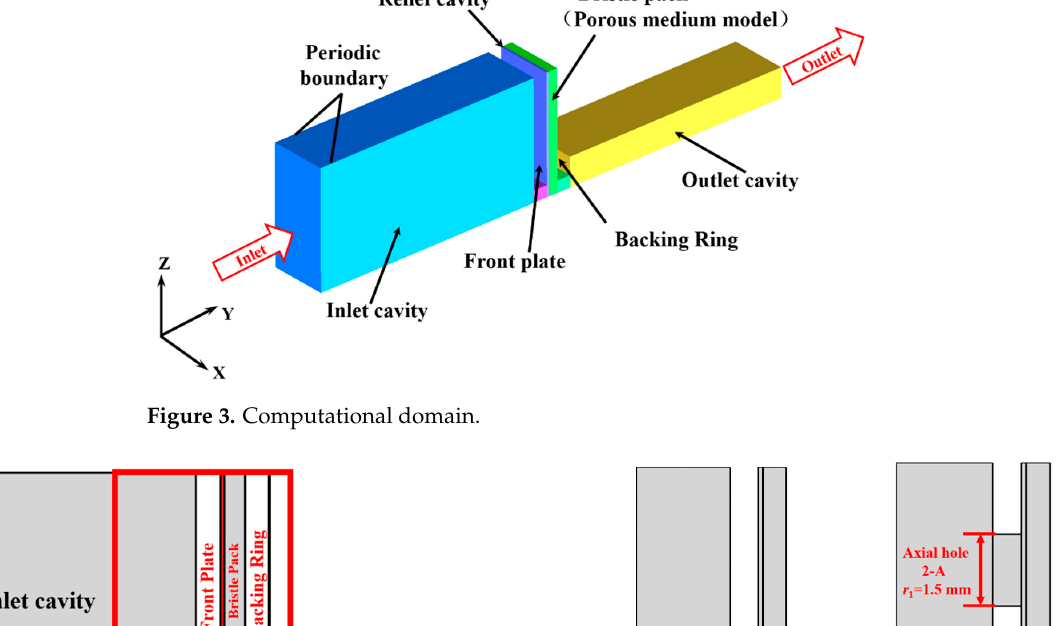
Figure 3. Computational domain.